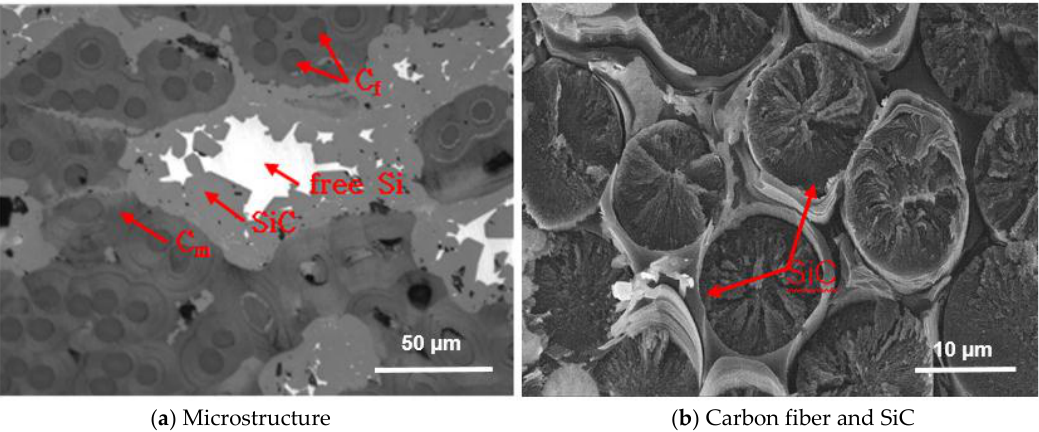
Figure 1. Microstructure of C/C-SiC composite showing the presence of SiC areas in the material. Note: C f is the C fiber, C m is the matrix.